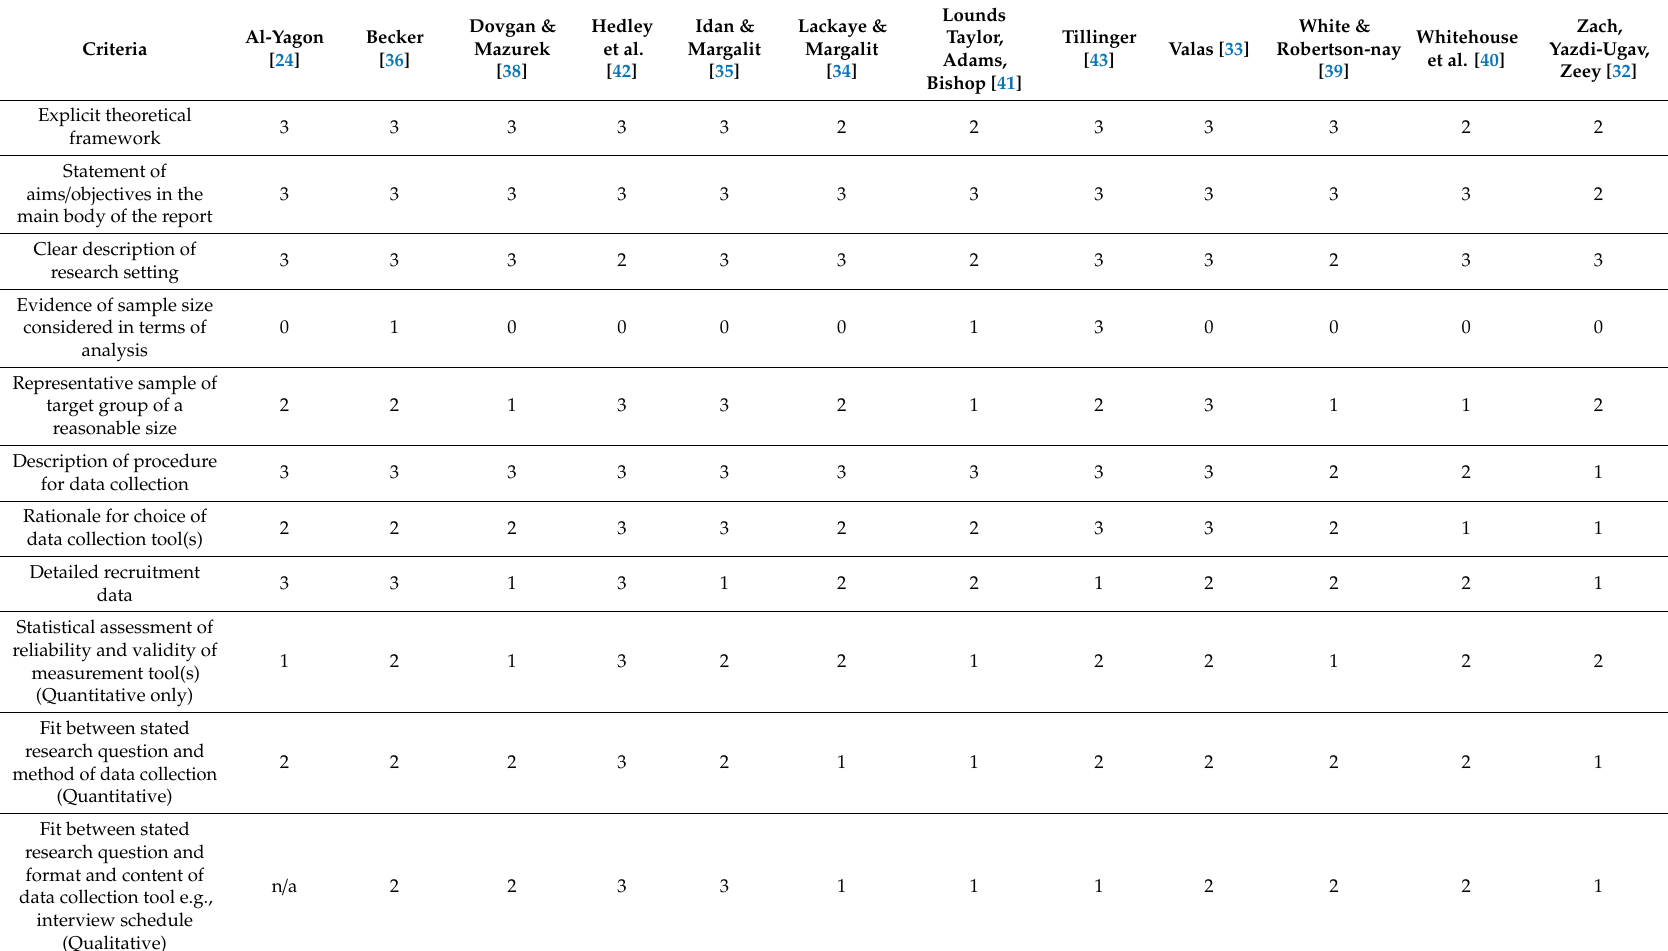
Table 2. Quality Assessment of the included studies based on the QATSDD